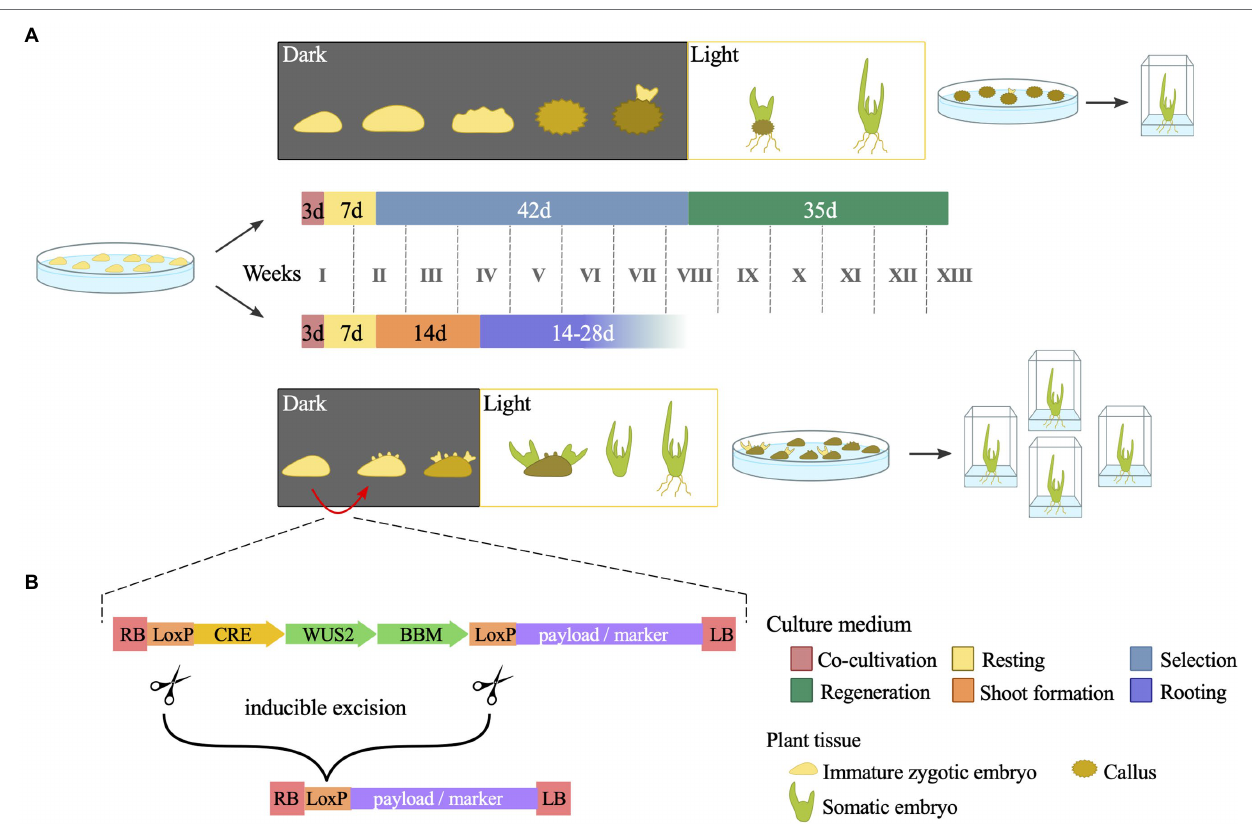
FIGURE 2 | Schematic representation of the morphogenic regulator-mediated maize transformation (MRMT). (A) Comparison between standard transformation (top) and MRMT (bottom) protocols. Tissue culture phases are indicated by different colours. By skipping the callus culture step, MRMT shortens the time needed for in vitro tissue culture. Note that although not specified, a selective agent is used in the MRMT culture media to allow regeneration of transformed embryos only. (B) Schematic representation of generic T-DNA present in MRMT-based vectors. In addition to the genetic payload of interest, T-DNA harbours morphogenic regulators (MRs) and a recombinase (CRE). Upon a given stimulus, CRE excises the MRs from the construct. The time period and culture media are based in Coussens et al. (2012) and Raji et al. (2018) for the standard protocol and in Masters et al. (2020) for the MRMT